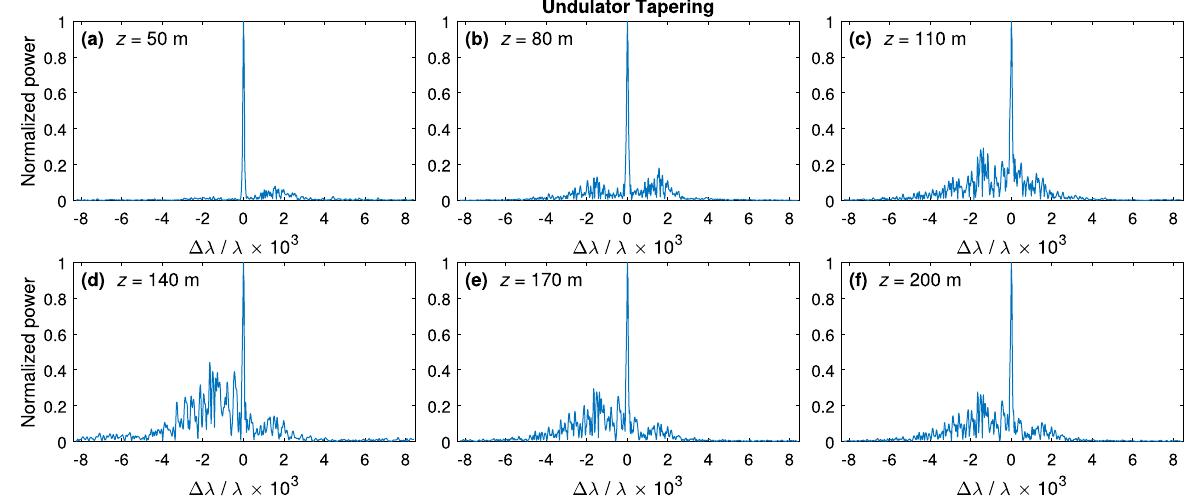
FIG. 11. Result of time-dependent simulation. The evolution of the optical spectrum for the optimal taper is illustrated with the snapshots at six positions along the undulator line.